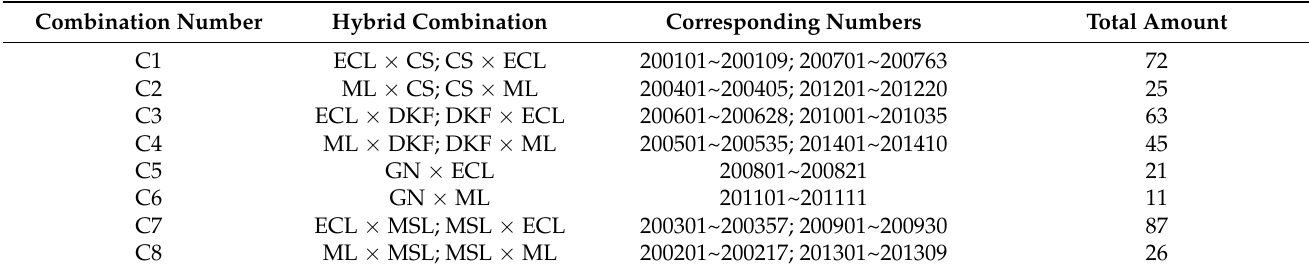
Table 1. Test materials used in this